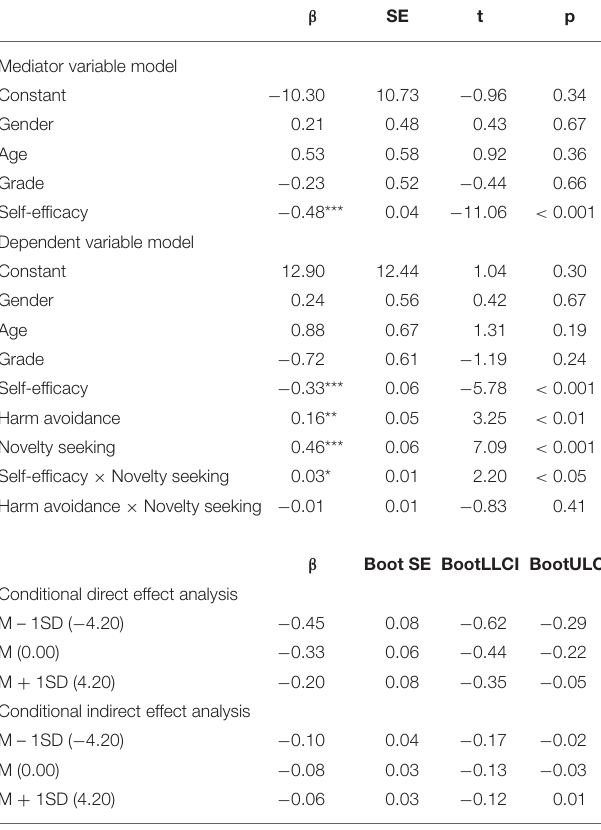
TABLE 2 | Mediation analysis for self-efficacy, harm avoidance (HA), and bedtime procrastination (BP).